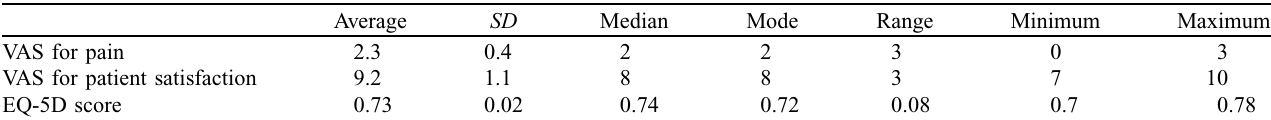
Table 3. Secondary outcome measures (visual analogue scales and quality of life score) 24 months post-operative.